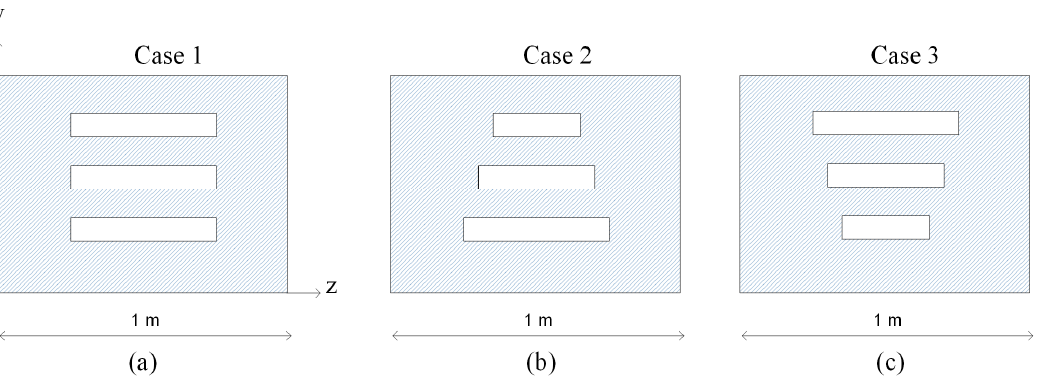
Figure 4. Various slot configurations on the solid baffle: ( a ) Slot widths are equal; ( b ) Slot width is decreasing in y direction and ( c ) Slot width is increasing in y direction.